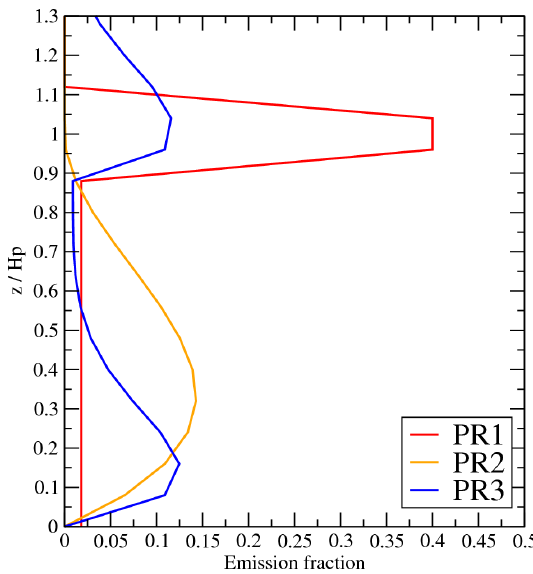
Figure 12. Vertical profiles of factors used for the vertical redistri- bution of the biomass burning emissions